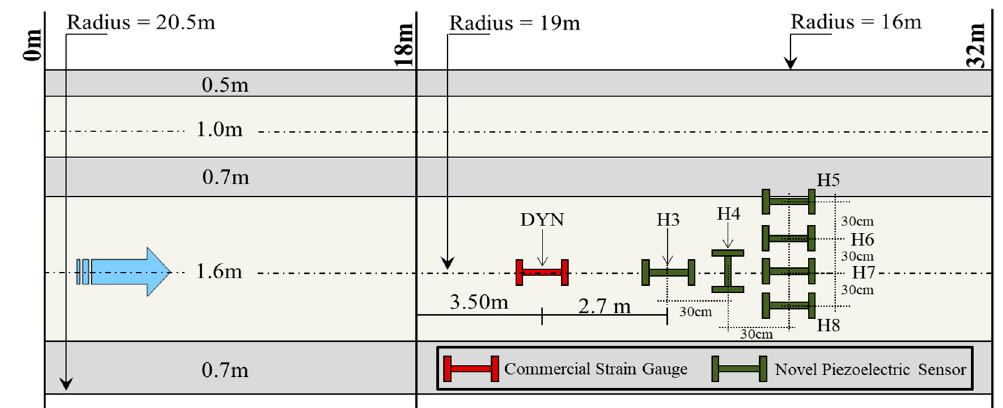
Figure 5. Schematic distribution of sensors within the pavement structure.